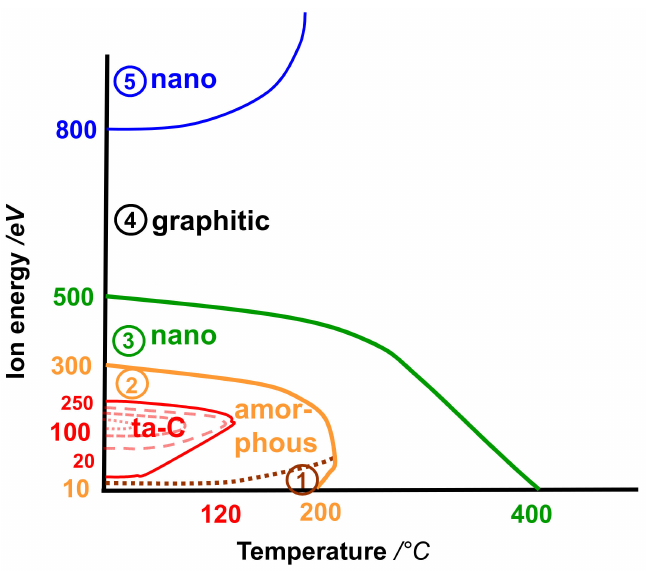
Figure 27. Hypothetical structural phase diagram of vacuum arc deposited carbon films. The temperature and energy values denote only typical